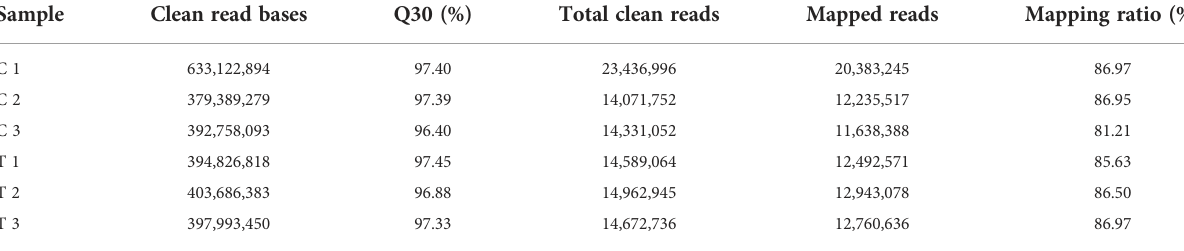
TABLE 3 Summary of the reads of miRNA libraries after quality control. Sample